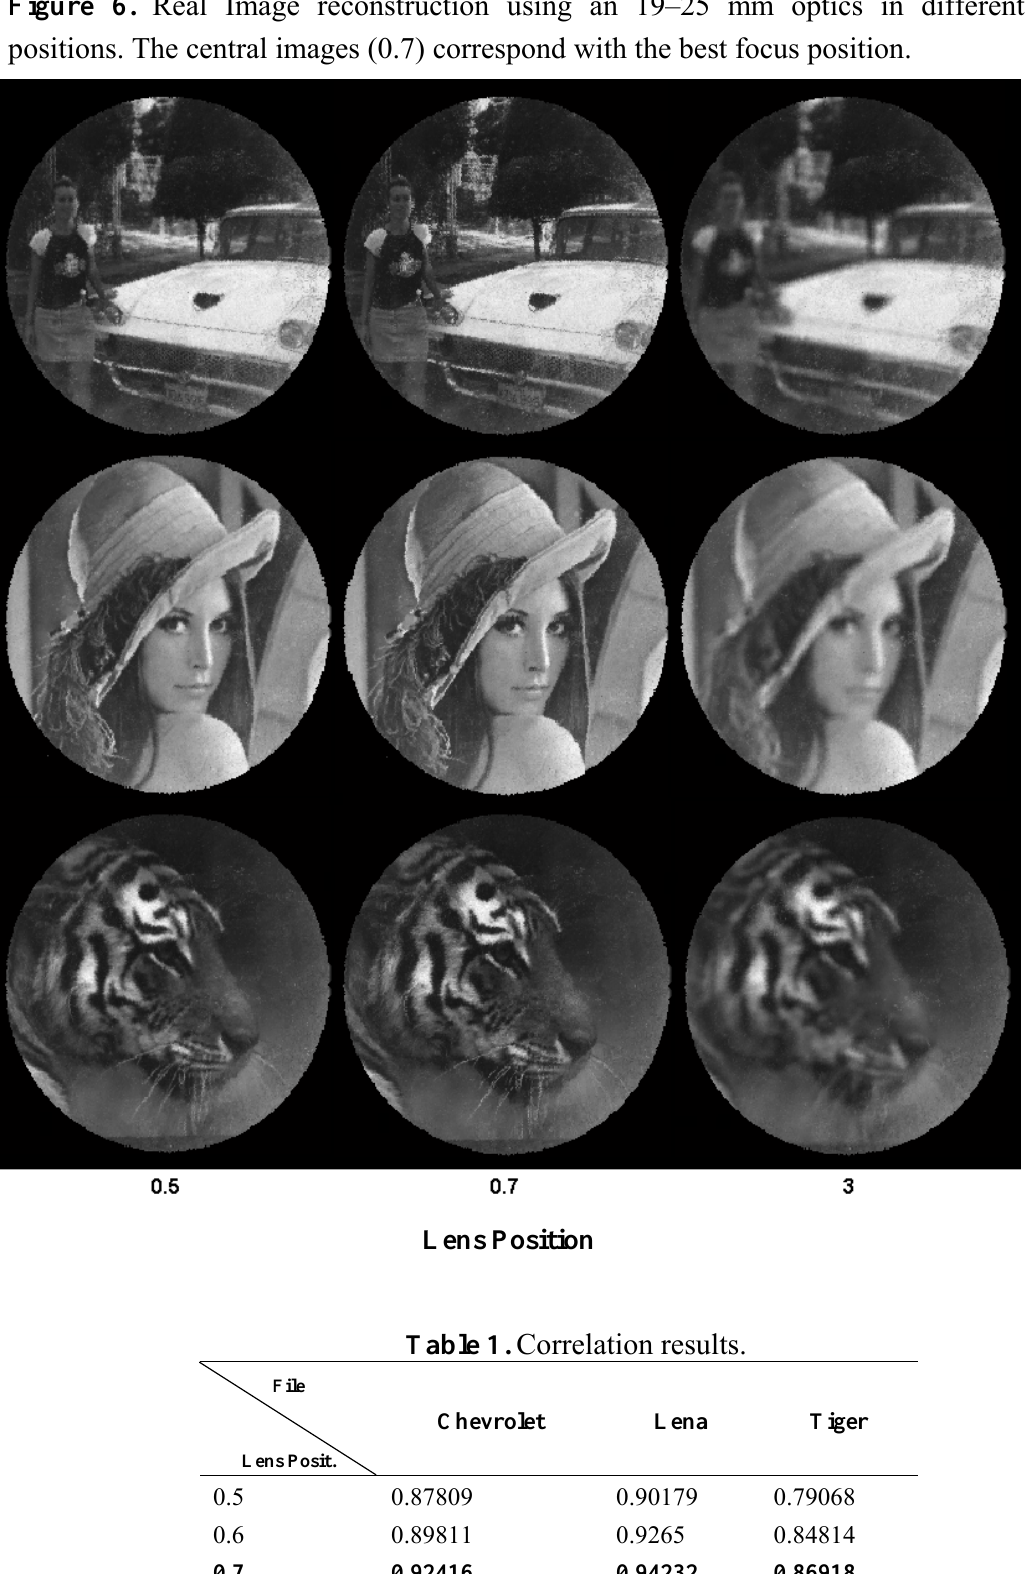
Figure 6. Real Image reconstruction using an 19–25 mm optics in different focus positions. The central images (0.7) correspond with the best focus position.